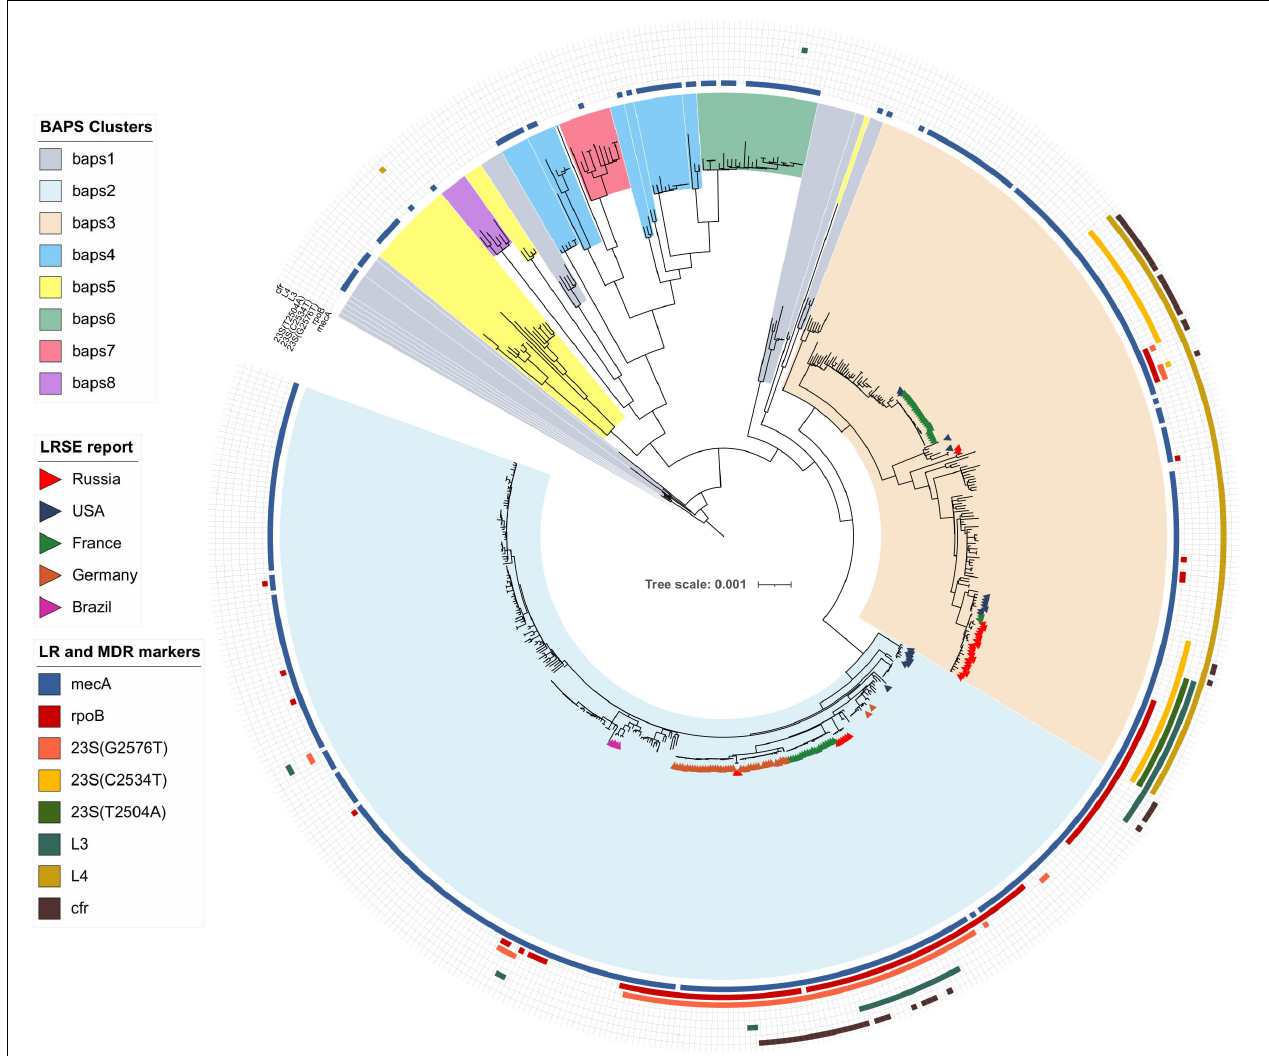
FIGURE 1 | Maximum-likelihood phylogeny of S. epidermidis population ( n = 554) with mapped data of linezolid resistance and multidrug resistance data. Background color fill is matched to BAPS clustering. LRSE isolate is marked triangles: from Russia (current study), the United States (Tewhey et al., 2014), France (Dortet et al., 2018), Germany (unpublished data, only metadata is available BioProject PRJNA314440), and Brazil (unpublished data, only metadata is available from BioProjects PRJNA419710, PRJNA419705, PRJNA419706, and PRJNA419711). Annotation from inner to outer circle: presence mecA , mutations in rpoB (rifampin resistance), linezolid resistance (mutations in 23S rRNA , rpl3, rpl4 genes and presence of cfr ). Full zoom scalable view of phylogenetic tree with additional data and names of strains and description of calculated acquired resistance genes are available in Supplementary Figure 1 .